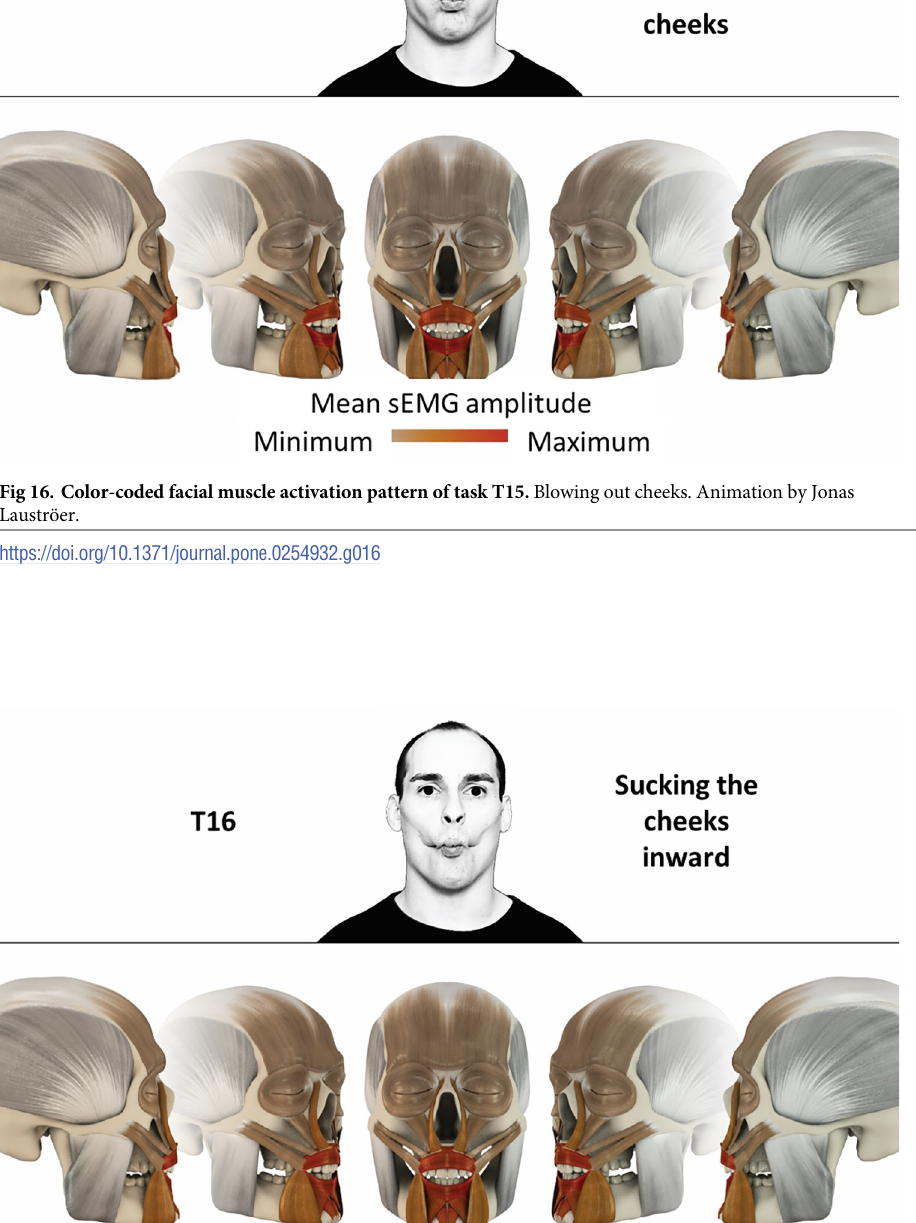
PLOS ONE | https://doi.org/10.1371/journal.pone.0254932 July 19,